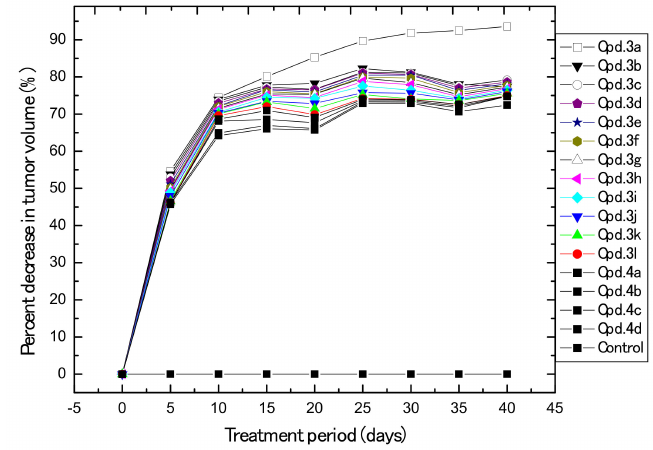
Figure 2. Percentages of decrease in tumor volume in nude mice in response to di ff erent synthesized